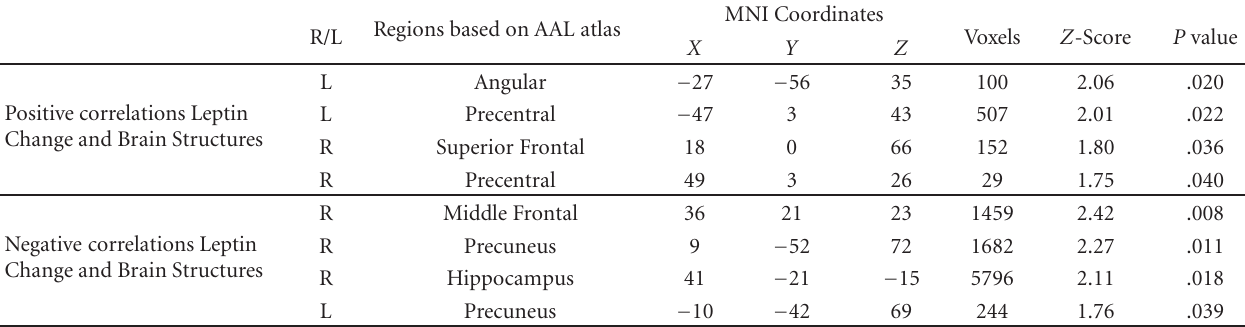
Table 4: Correlations between grey matter volumes and fasting leptin levels changes observed in schizophrenia patients after olanzapine